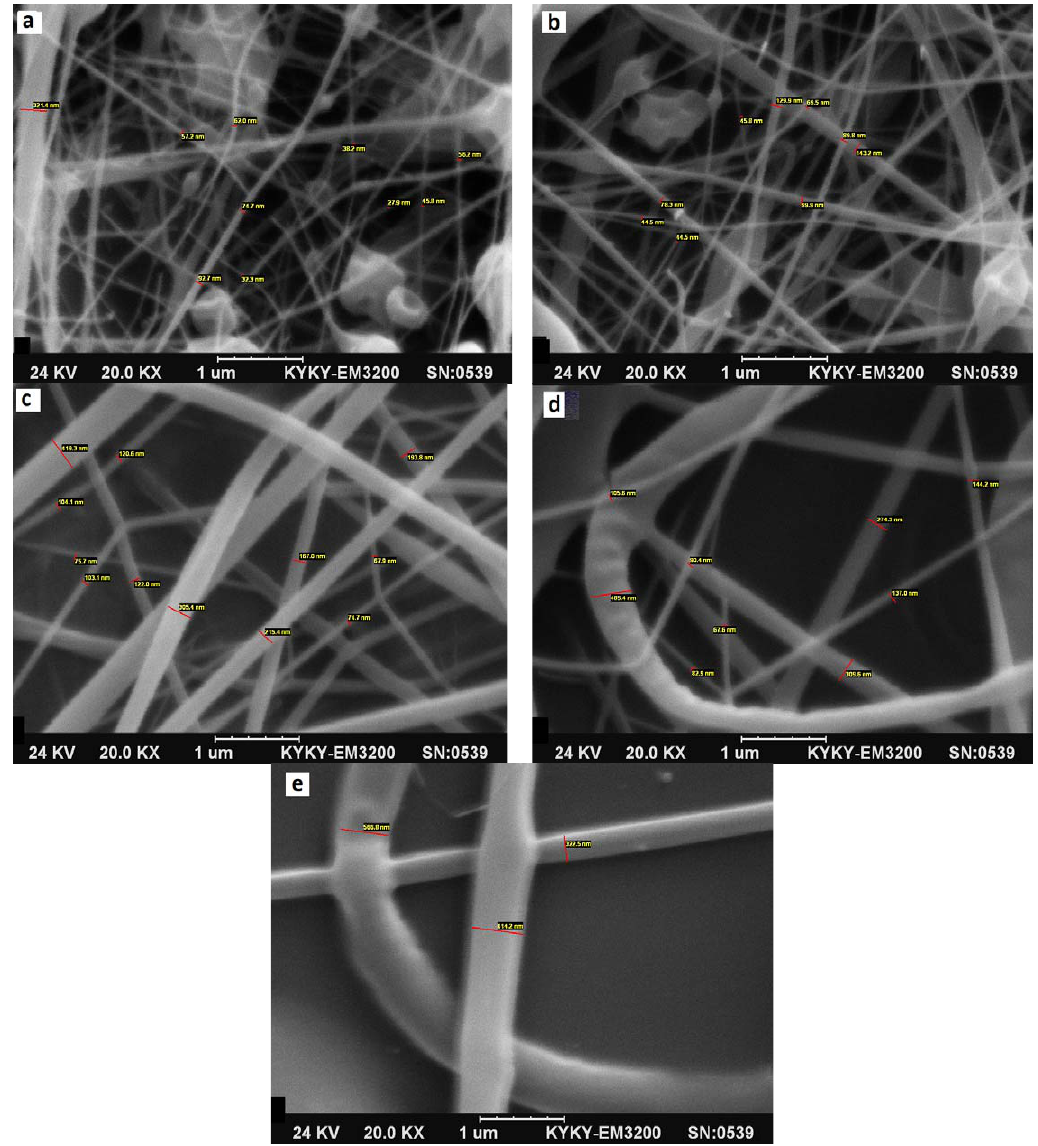
Fig.7. SEM images of as-spun CA fiber mats from different amounts of CA solutions ((a) 8%, (b) 10%, (c) 12%, (d) 14% and (e) 16%) in 3:1 (v/v)